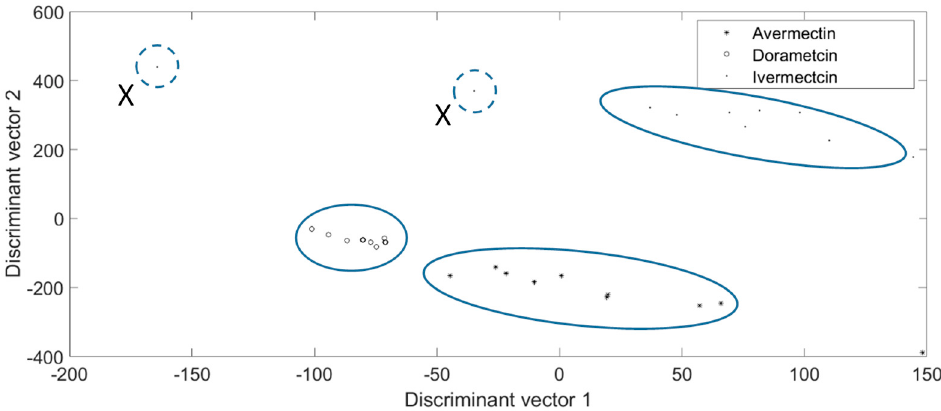
Figure 4. The sensitivity evaluation results of the proposed chip tested by in 0.01 mg / Kg of avermectins. The figures are gathered by groups and the distance between different chemicals is distant.